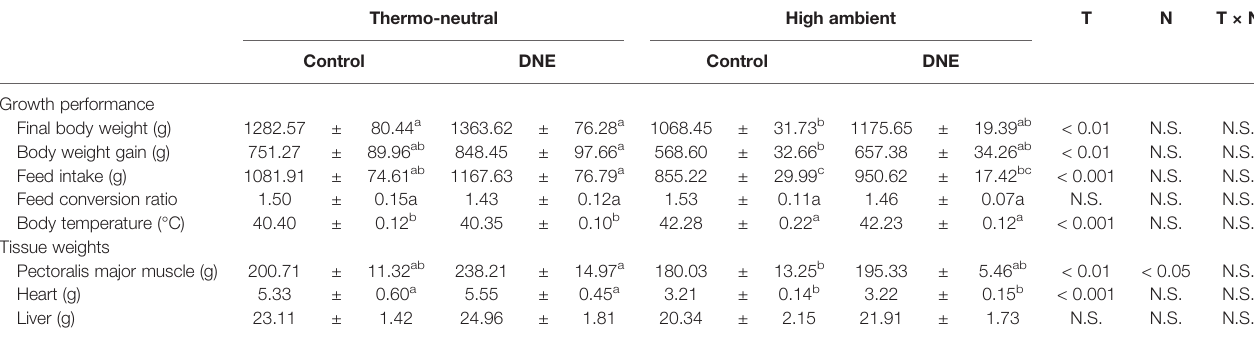
TABLE 2 | Effects of dietary supplementation with DNE on growth performance and tissue weights of broiler chickens under high temperature conditions. Thermo-neutral